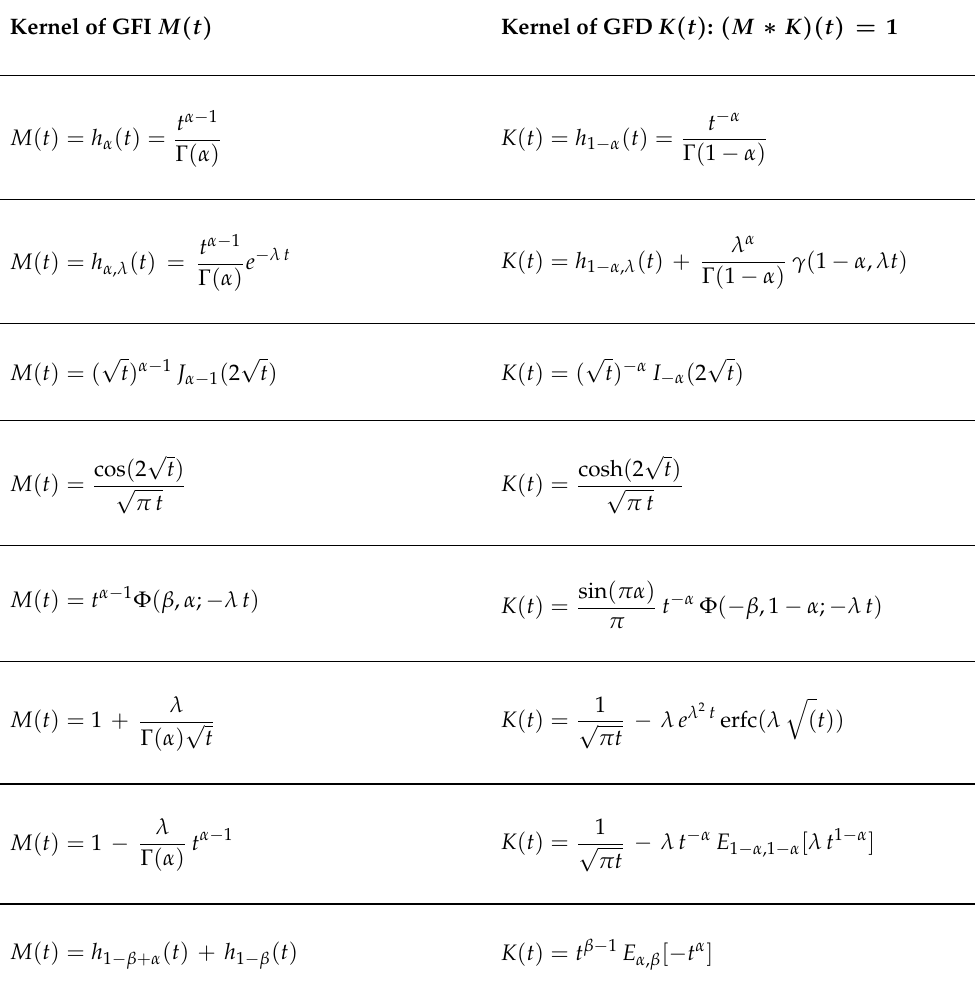
Table 1. Examples of the kernel pairs that belong to the Sonin set and Luchko set, where 0 < α < 1 and 0 < α < β < 1, λ 0, t > ≥